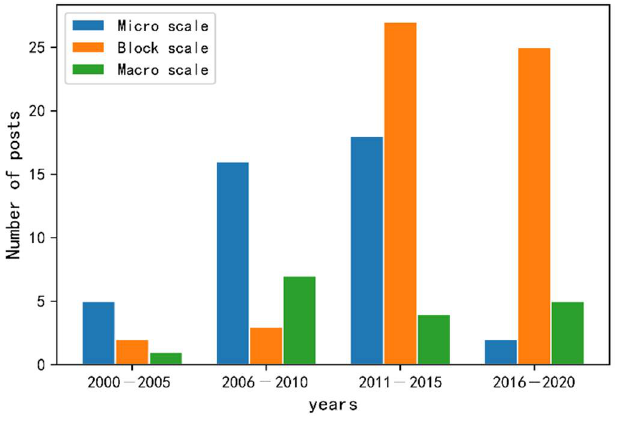
Figure 5. Publications focusing on three scales in CFD-based USTE simulation.